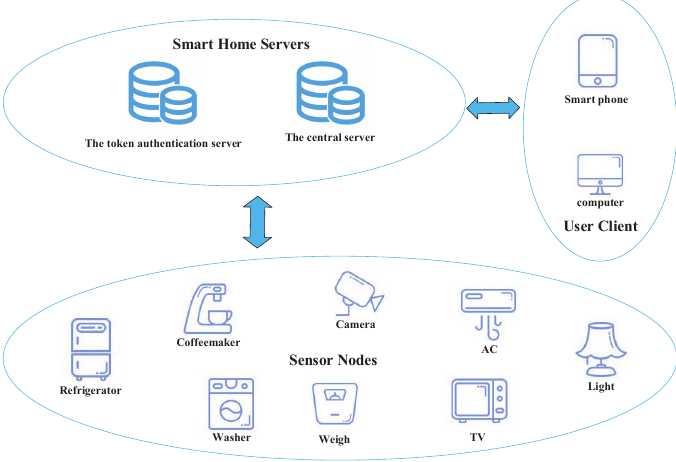
Figure 1. The proposed smart home